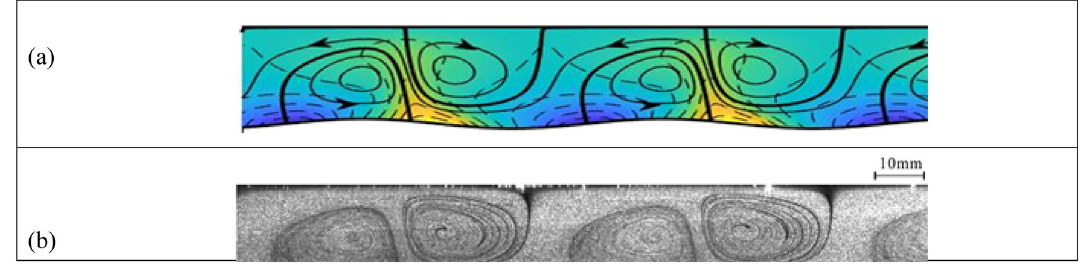
Figure 4. Convection for the same conditions as in Fig. 3 but with the position of the heating pattern characterized by the phase difference � = − π/ 2 . ( a ) Theory; ( b ) experiment (Supplementary movie C2).